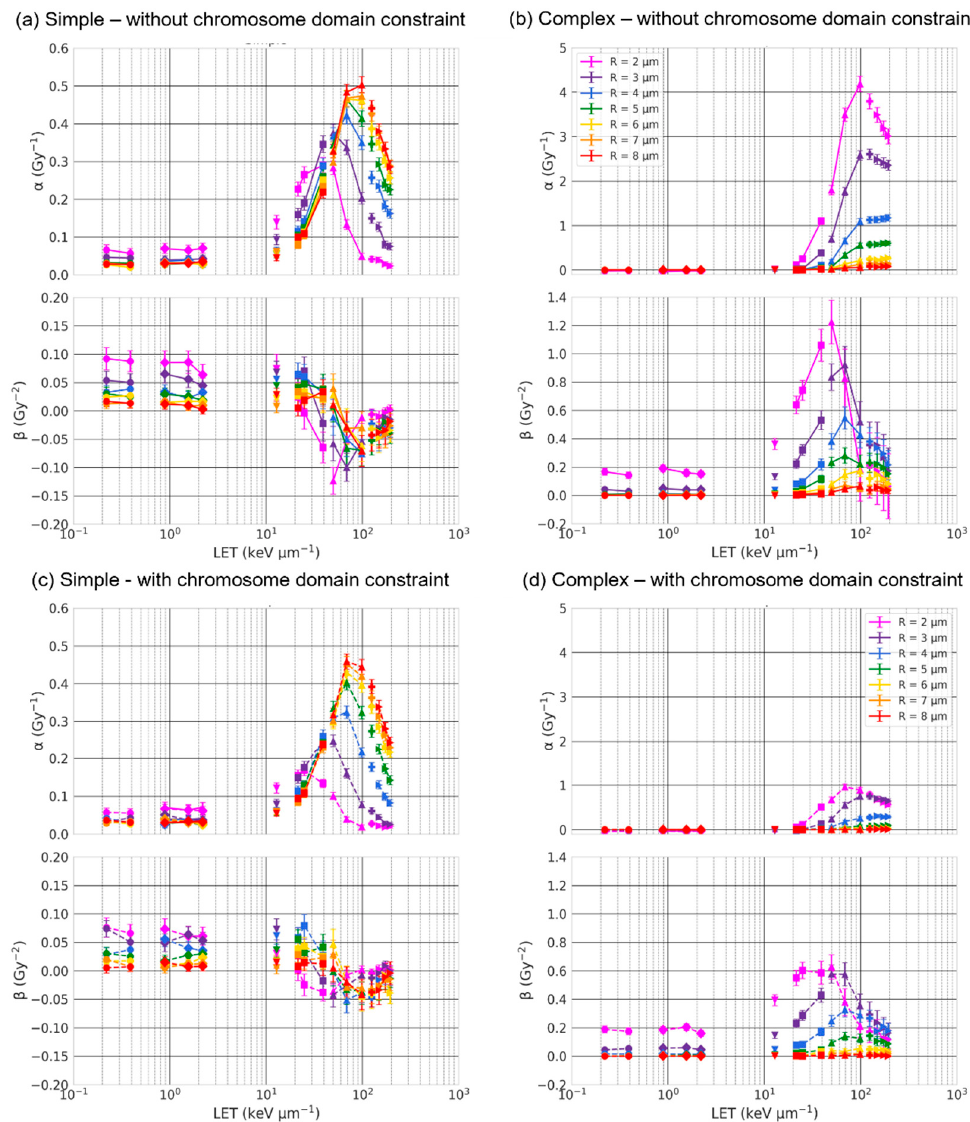
Figure 5. 𝛼 and 𝛽 coefficients of simple ( a , c ) and complex ( b , d ) exchanges as a function of LET and for spherical nuclei of radii varying from 2 µ m to 8 µ m. Solid (without chromosome domain constraint ( a , b )) and dashed lines (with chromosome domain constraint ( c , d )) are plotted as straight lines between RITCARD datapoints for a given ion type. Circle: H (1000 MeV, 250 MeV); Diamond: He (1000 MeV/n, 250 MeV/n, 150 MeV/n); Triangle down: C (290 MeV/n); Square: O (325 MeV/n, 250 MeV/n, 128 MeV/n); Triangle up: Si (600 MeV/n, 300 MeV/n, 170 MeV/n); Plus: Ti (600 MeV/n); Triangle right: Fe (1000 MeV/n, 600 MeV/n, 450 MeV/n).